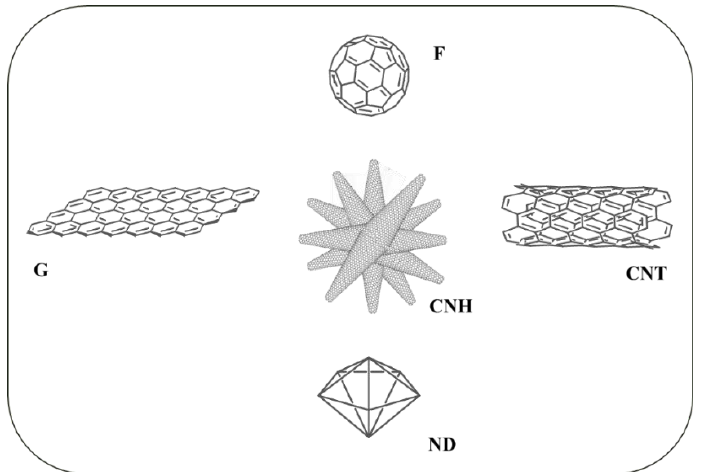
Figure 1. Representation of the main carbon nanostructures.